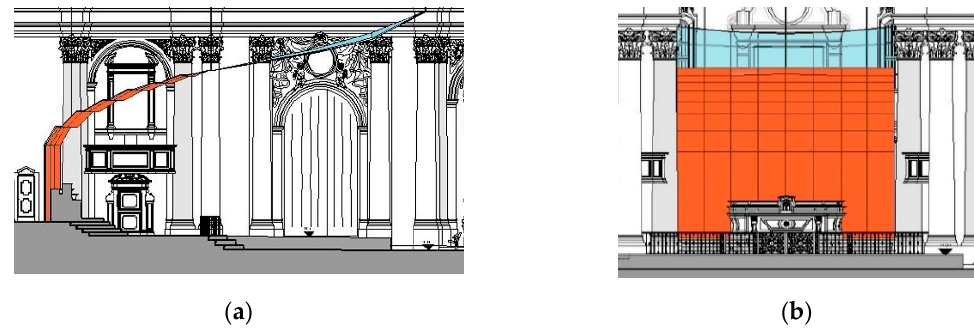
Figure 9. Acoustic design of the shell in S. Dominic of Imola: lateral ( a ) and front ( b ) elevations.